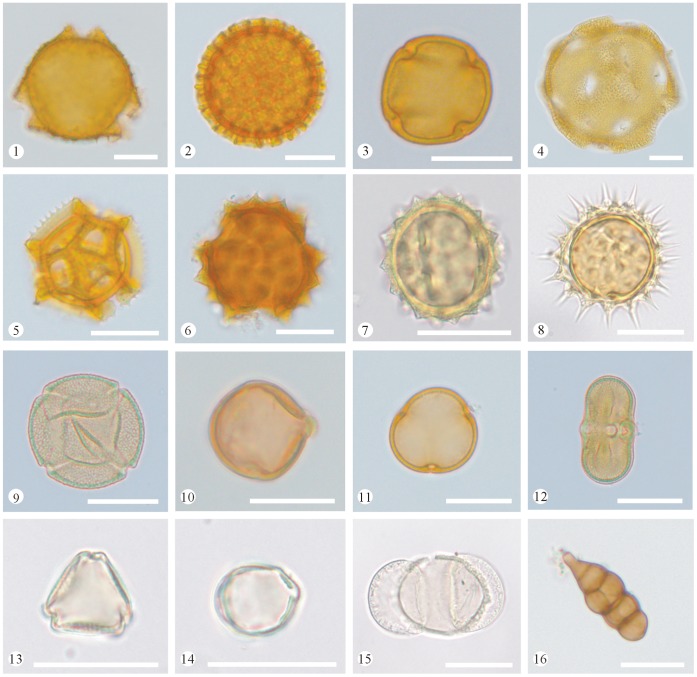
Photomicrographs of selected pollen grains recovered from the honey samples (continued).1. Lonicera maackii (Caprifoliaceae), 2. Syringa sp. (Oleaceae), 3. Meliaceae type, 4. Convolvulus arvensis (Convolvulaceae), 5. Taraxacum mongolicum (Asteraceae), 6–8. Asteraceae type, 9. Polygonaceae type, 10. Robinia pseudoacacia (Fabaceae), 11. Unidentified pollen, 12. Apiaceae type, 13–14. Ziziphus jujuba (Rhamnaceae), 15. Pinus sp. (Pinaceae), 16. Fungi spore (Scale bar = 20 µm).